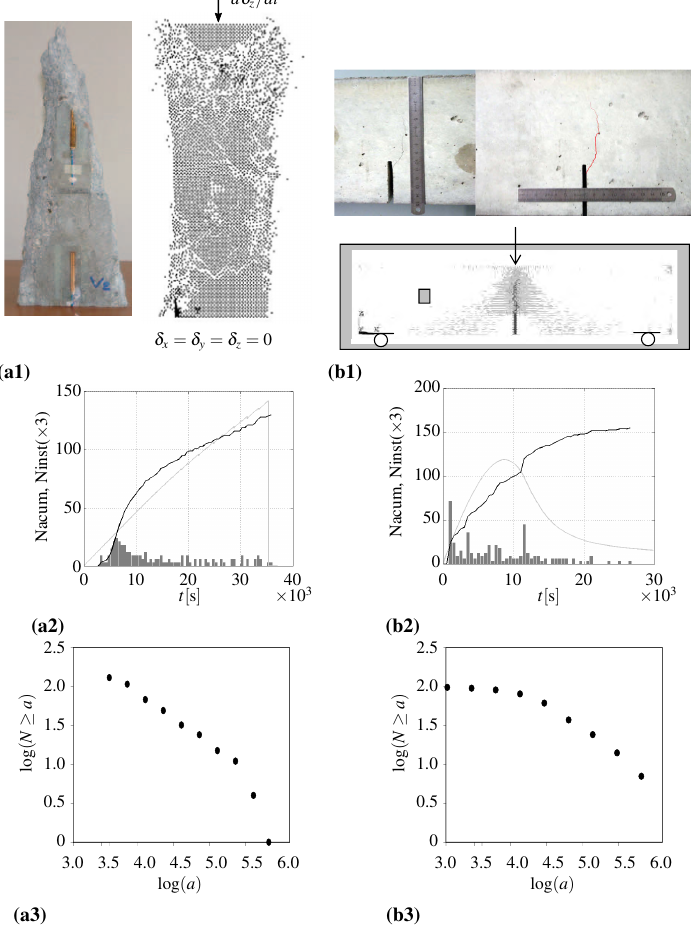
Figure 18. AE simulation results on concrete structures. ( a ) prism under uniaxial compression, ( b ) pre-fissured beam. ( 1 ) Results in terms of final configurations. ( 2 ) load vs time response (light- gray line), accumulated number of AE signals (dark line), and instantaneous distribution of events (histogram bars) ( 3 ) Accumulated number of signals vs. their magnitudes in bilogarithmic scale